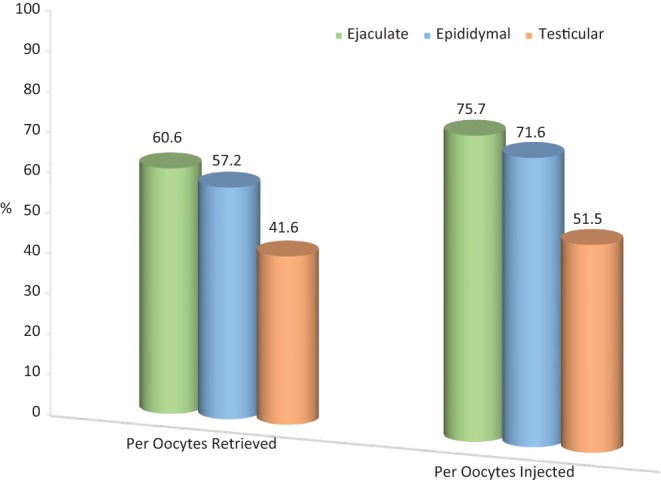
Comparison of fertilization rates according to spermatozoa source. Ejaculated specimens yielded a fertilization rate comparable to the epididymal and both were superior to testicular spermatozoa per oocytes retrieved (χ2, 2 × 3, 2 df; P < 0.0001). A similar pattern was observed once the fertilization rate was calculated based on the number of metaphase II oocytes injected (χ2, 2 × 3, 2 df; P < 0.0001).